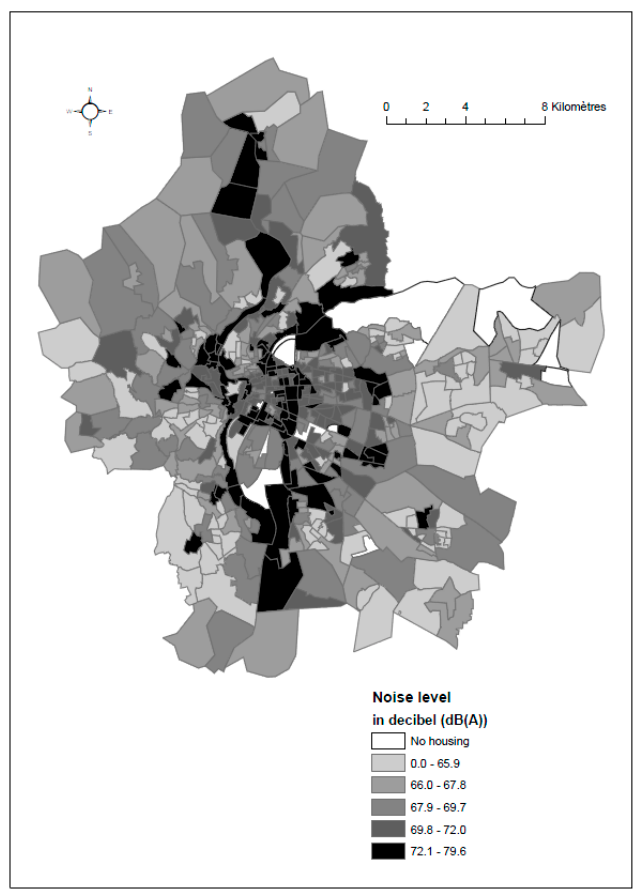
Figure 4. Spatial distribution of noise exposure (the weighted Lden noise indicator) at census block level based on quintiles of the distribution.